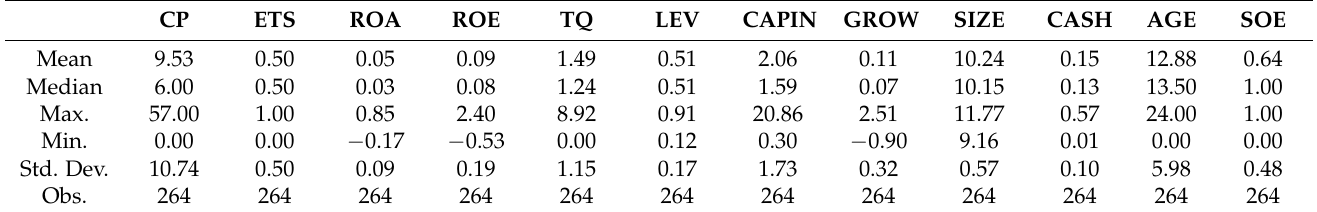
Table 4. Descriptive statistics: All Firms.